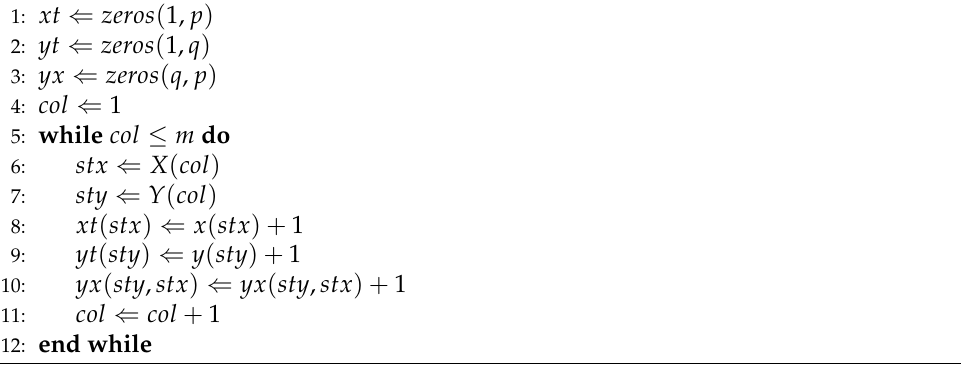
Algorithm 2 Calculate [ xt , yt , yx ] = GetIn f o ( X , Y , p , q , m )